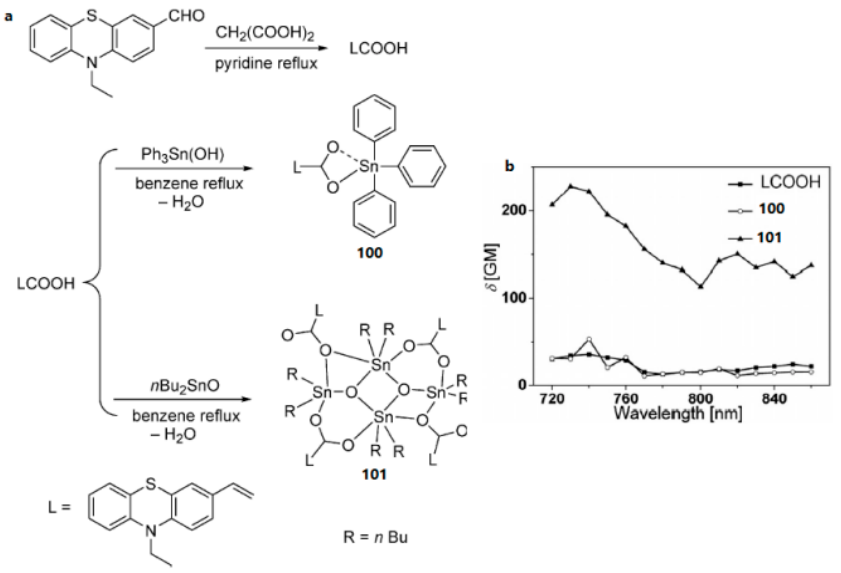
Figure 28. ( a ) Synthesis of the organotin carboxylate derivatives LCOOH, 100 , and 101 ; ( b ) 2PA spectra of LCOOH, 100 , and 101 .